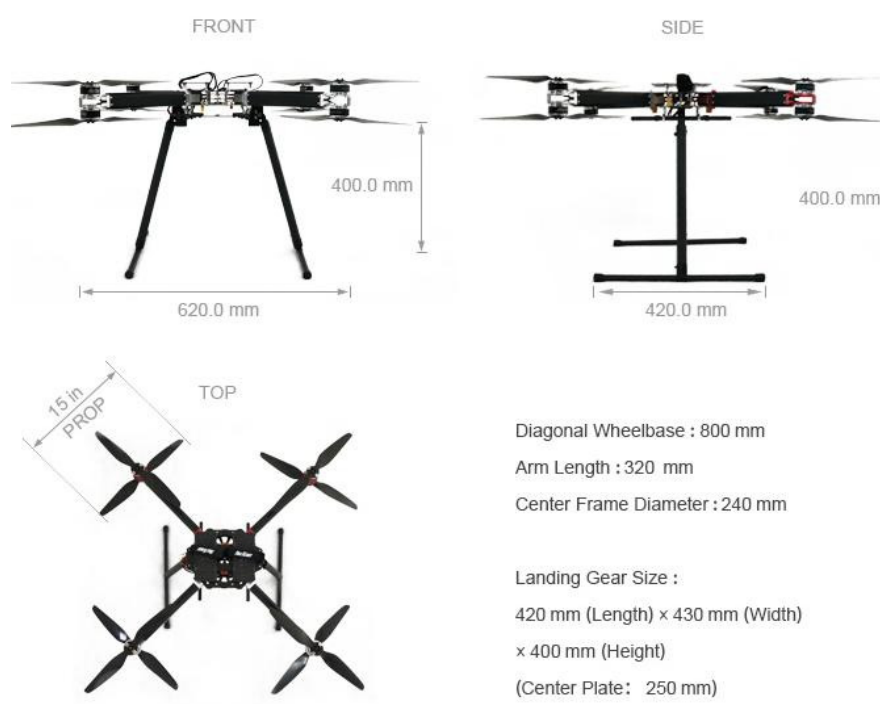
Figure 4. FlyBit octocopter and main features.